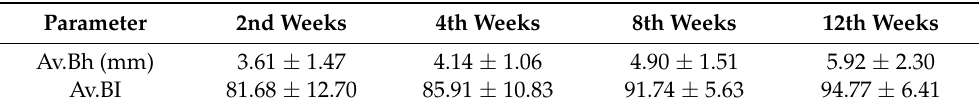
Table 3. The mean and standard deviation of new alveolar bone height (Av.Bh) and alveolar bone intensity (Av.Bi) of post-extraction socket preservation in 2nd, 4th, 8th and 12th weeks. Parameter 2nd Weeks 4th Weeks 8th Weeks 12th